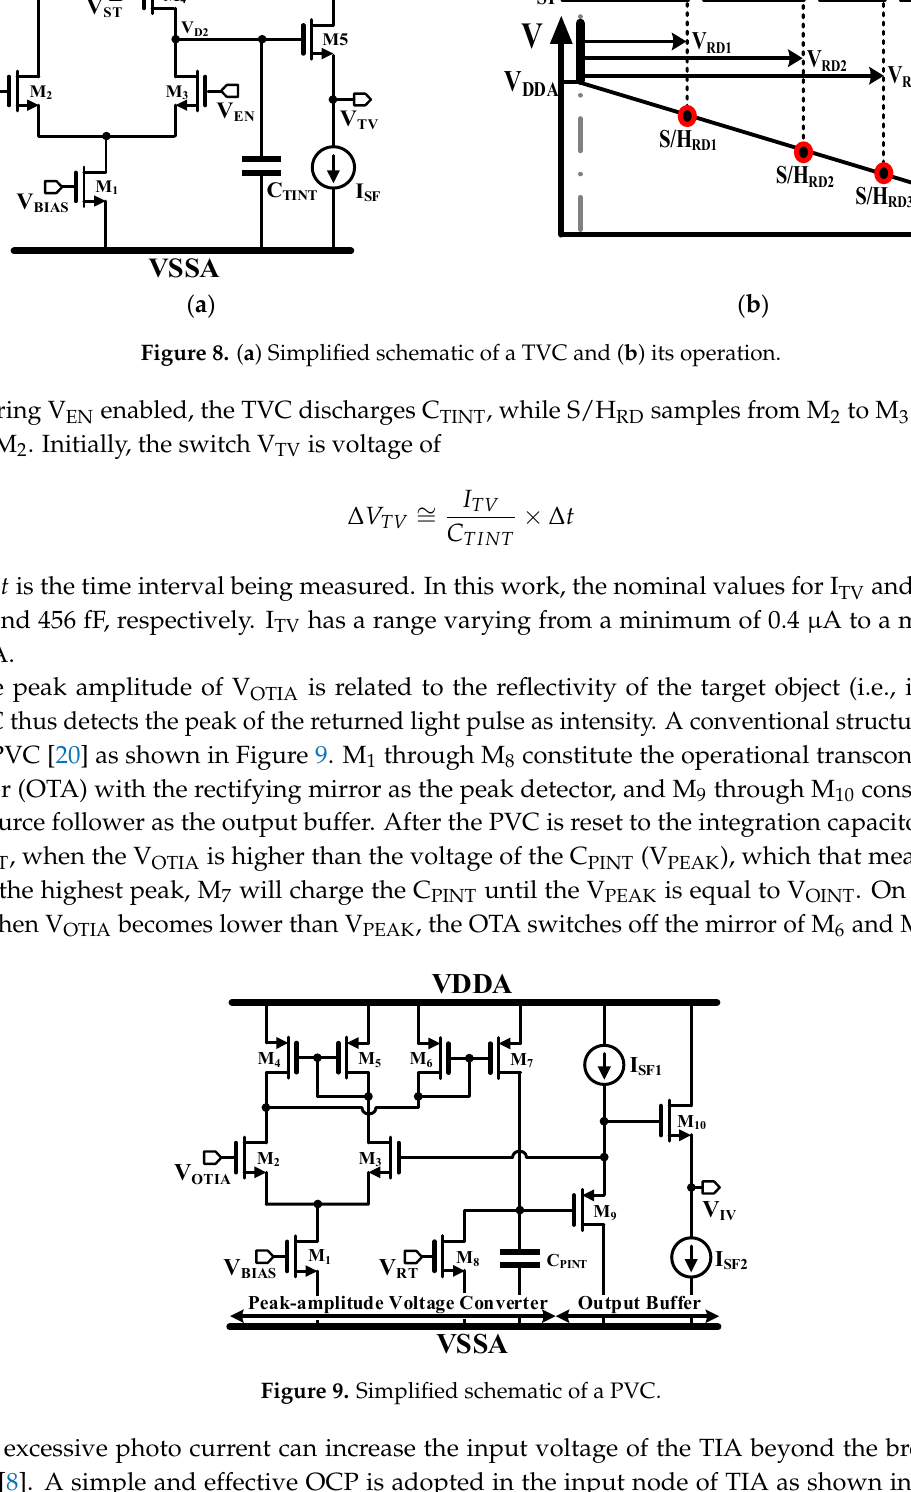
Figure 7. Simplified schematic of a timing comparator.